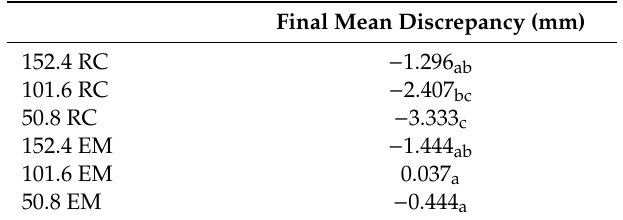
Table 7. Mean final discrepancies between set position of the electric actuator and final position of the hydraulic